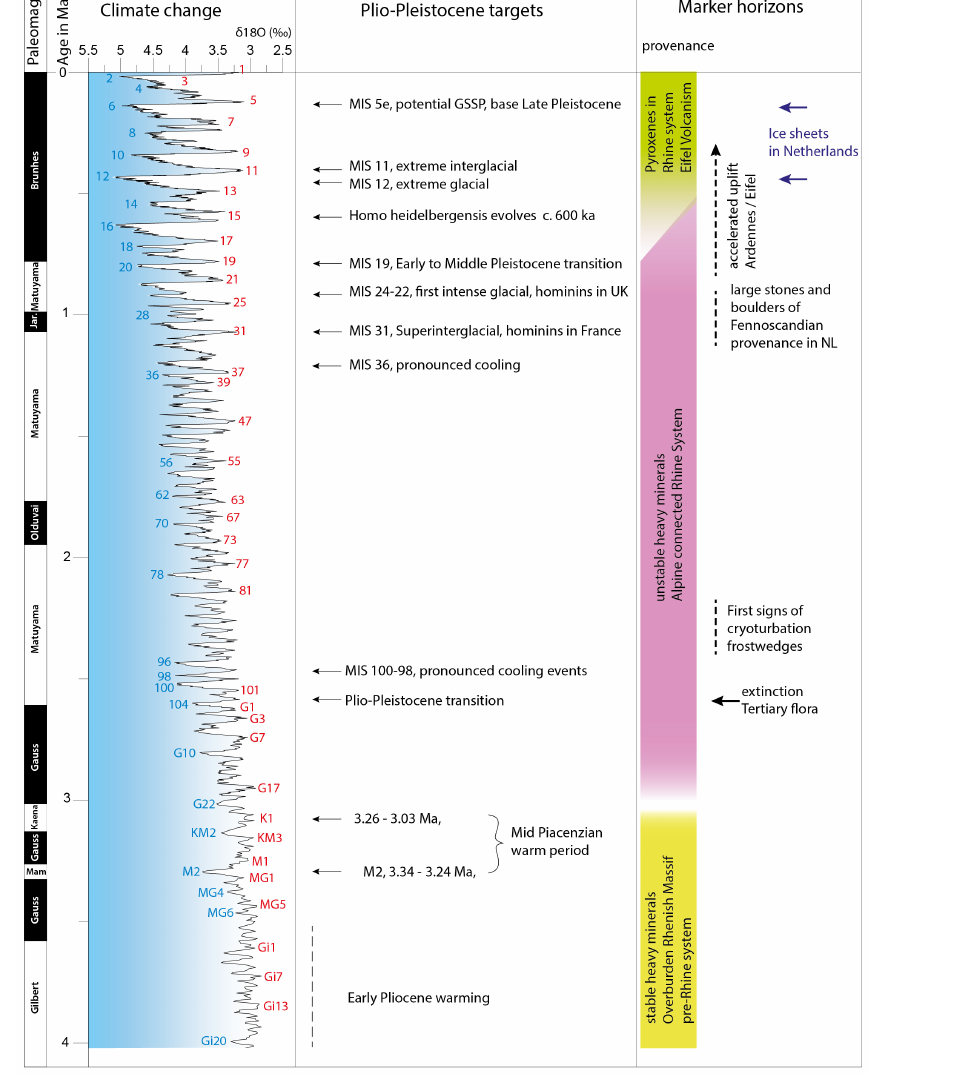
Figure 2. Late Pliocene–Pleistocene targets against the deep see benthic oxygen isotope stack of Lisiecki and Raymo (2005). The cli- mate/vegetational context is very important for landscape reconstruction with respect to the northward migration of